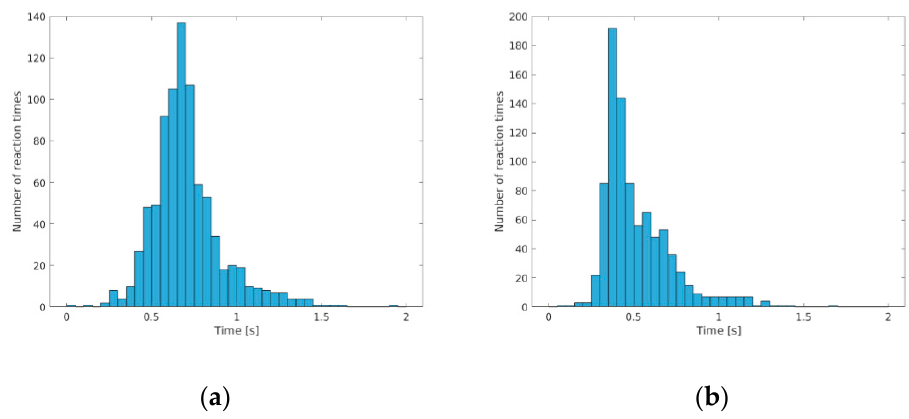
Figure 8. Reaction times. ( a ) Without sound; ( b ) with sound notification.